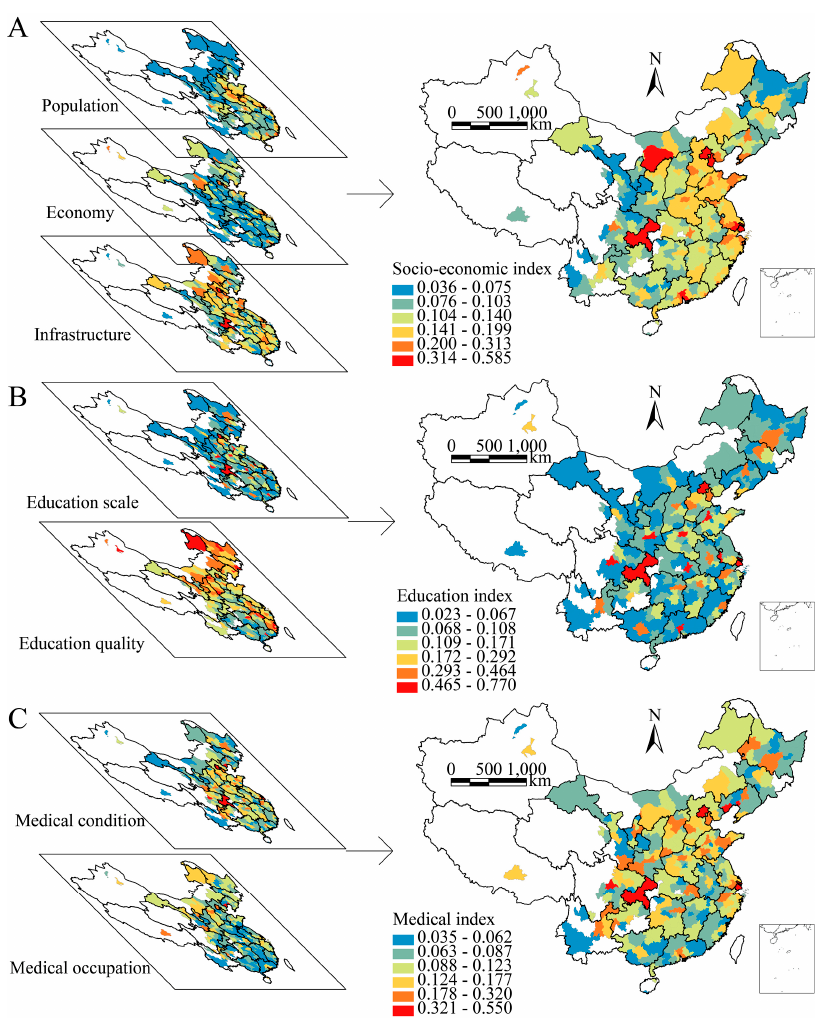
Figure 6. Distributions of entropy weighted socioeconomic development level index ( A ), education level index ( B ) and medical level index ( C ). The gradual changes from low values (blue) to high values (red) present the conditions get better.